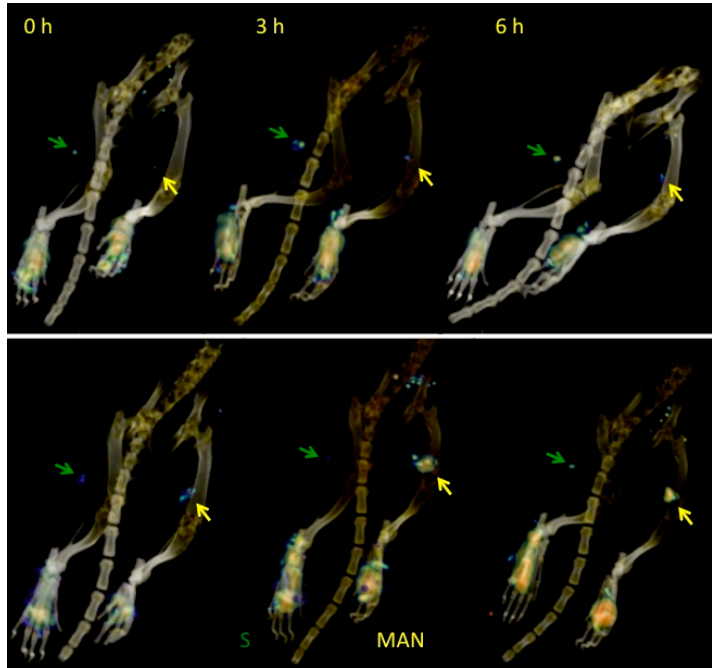
Figure 6. MicroSPECT/CT images of two different rats at different times, illustrating the differences in the lymphatic mapping of 99m Tc-Sulfur colloid (S) and 99m Tc-AuNPs-MAN 48h (MAN). Arrows indicate the location of the lymph nodes. Animals were oriented in a prone position.